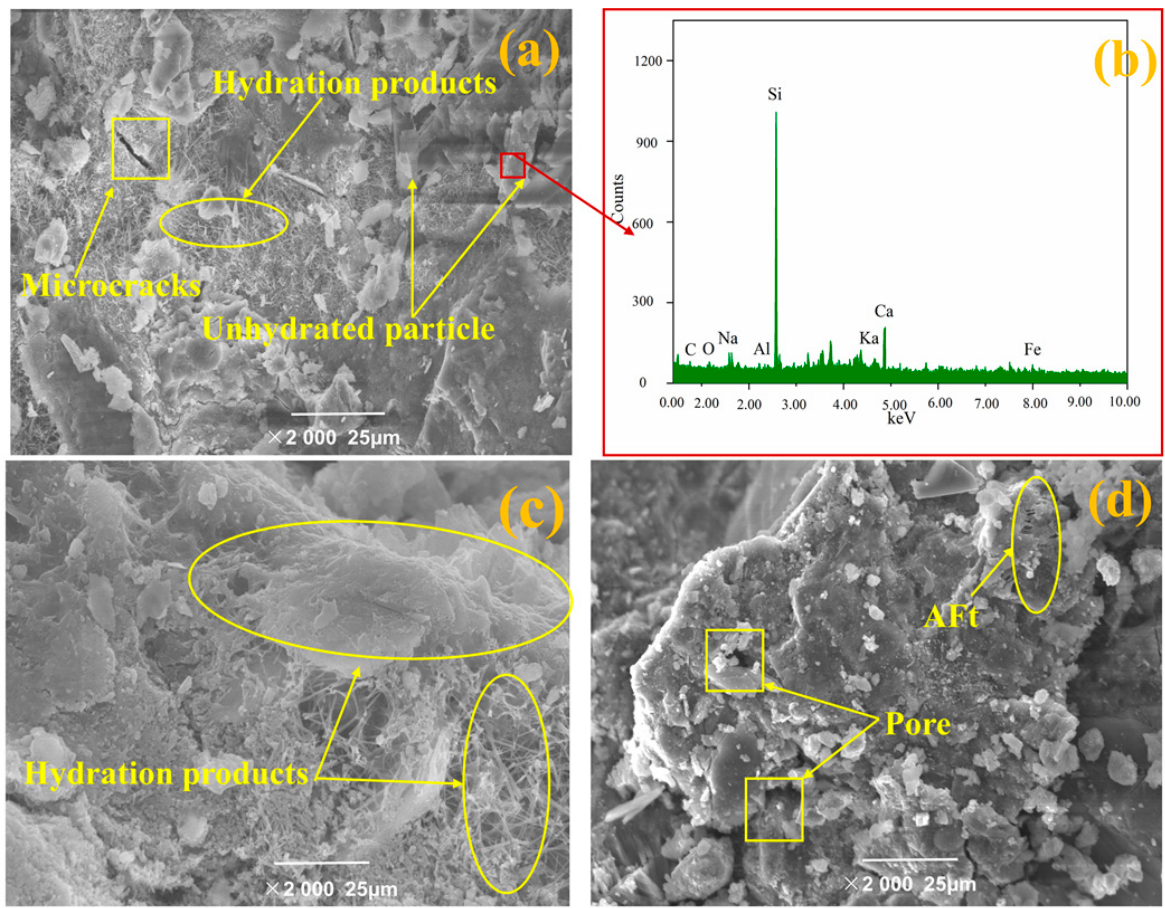
Figure 7. The microstructure of concrete: ( a ) the C100ITP0 sample; ( b ) XRD analysis of the unhydrated particle (red square), it indicates that the unhydrated particle was ITP; ( c ) C85ITP15 sample, and ( d ) C70ITP30 sample.